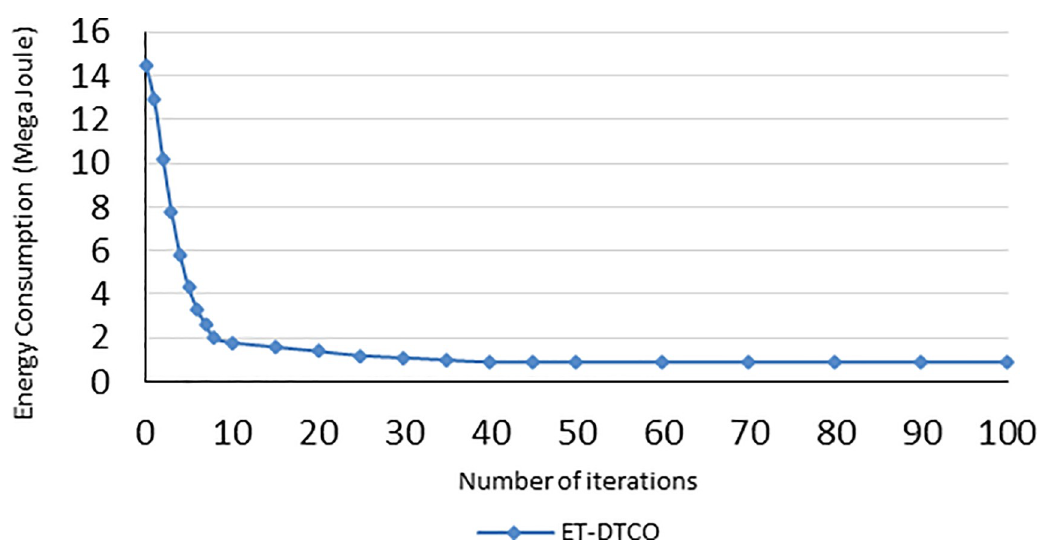
Fig 6. Energy consumption depends on the number of